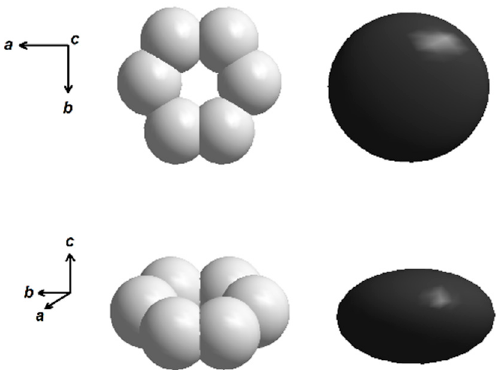
1–x Pb x Fe 12 O 19 .